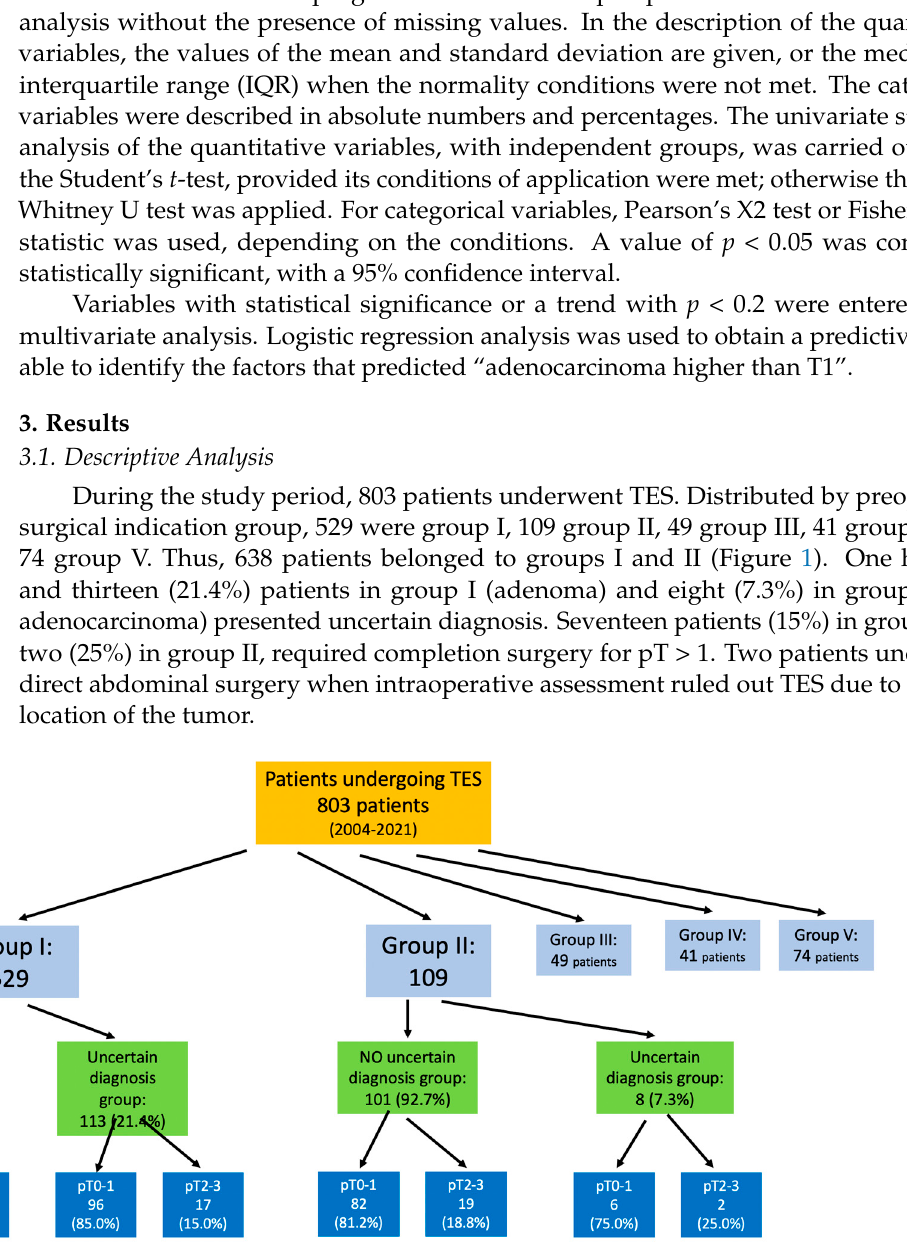
Table 1. Patients’ demographic characteristics and preoperative data of tumors in groups I and II.